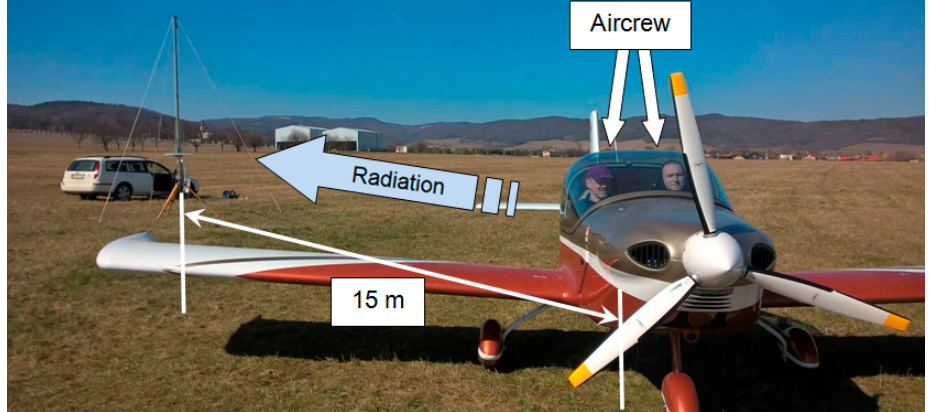
Figure 7. Measurement at a small position angle θ of 2° at a distance of 15